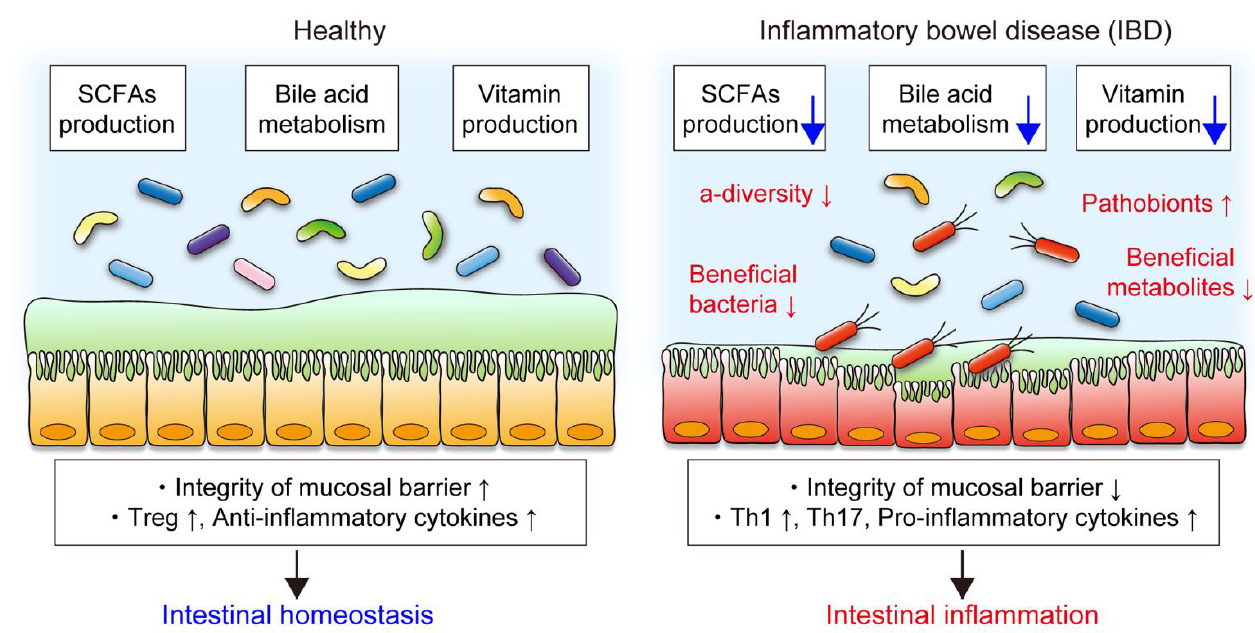
Figure 2. Functional changes in the gut microbiota in IBD. The gut microbiota produces short-chain fatty acids (SCFAs) and vitamins and deconjugates bile acids, which play crucial roles in mucosal barrier and immunity. In patients with IBD, decreased α-diversity, reduced abundance of beneficial bacteria and metabolites, and increased pathobionts are the common features of gut dysbiosis. Gut dysbiosis is accompanied by functional alteration of the gut microbiota. In particular, decreased SCFA production, bile acid metabolism, and vitamin production in the gut microbiota in IBD are associated with impaired mucosal barrier integrity and abnormal immune reactions, resulting in intestinal inflammation.